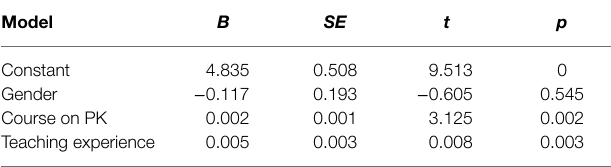
TABLE 5 | Results of multiple regression analyses with PK as criterion. Model